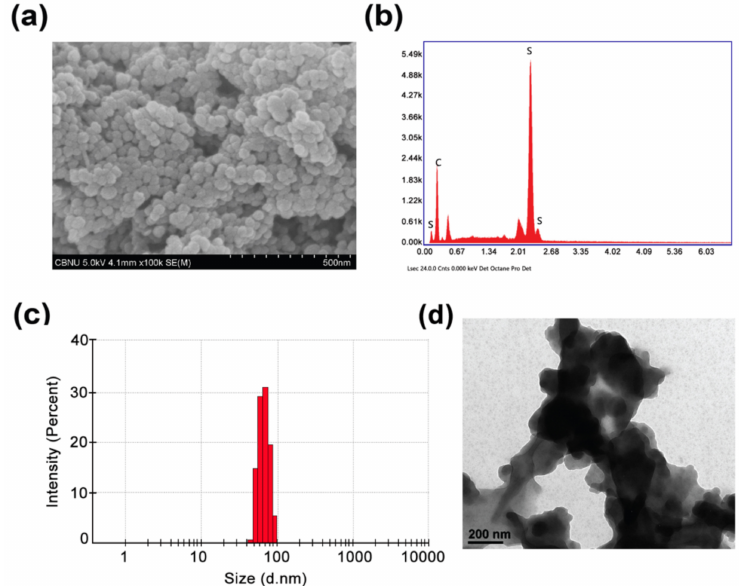
Figure 1. Physicochemical characterization of polythiophene particles. ( a ) FESEM image, and ( b ) EDX mapping of PTh–NPs, which shows the presence of C and S elements, which are the constituent elements of polythiophene. Particles size dirstribution diagram by ( c ) DLS anaysis and ( d ) by Biological Transmission Electron